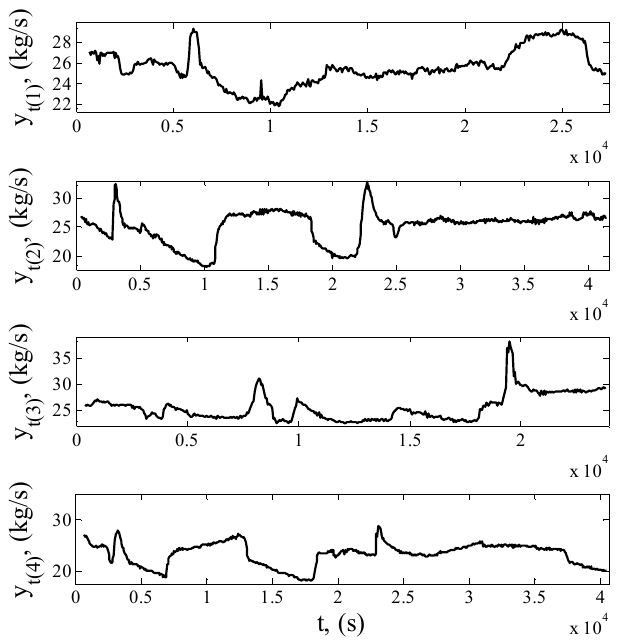
Figure 10. Time courses of the feed solids flow rate determined by means of the third-order ARMA model with Equation (21).